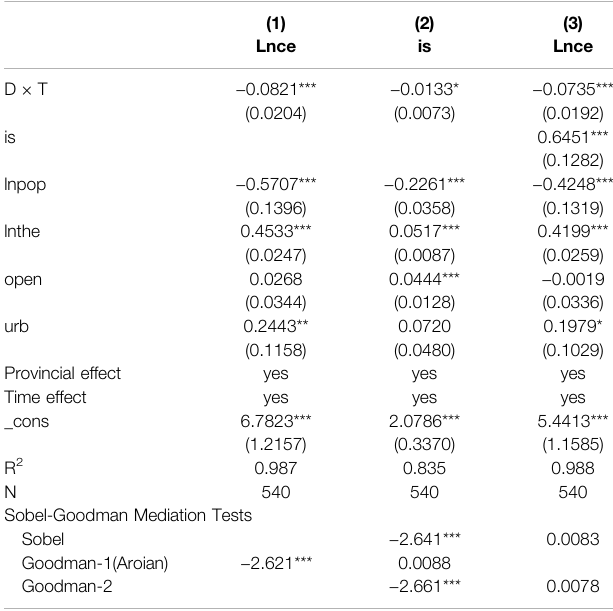
TABLE 7 | Intermediary test of industrial